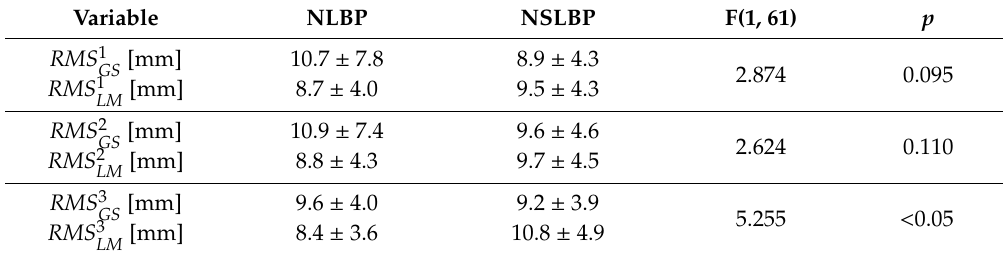
Table 5. Results of RMS i ∗ and two-way mixed analysis of variance.